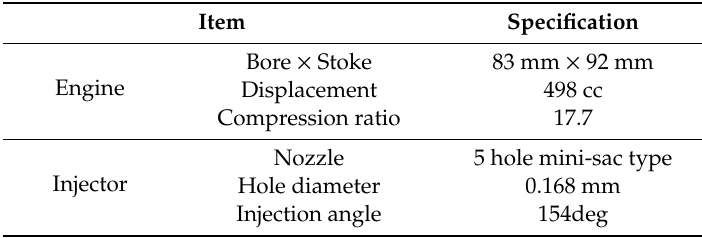
Table 1. Specifications of test engine and test nozzle.